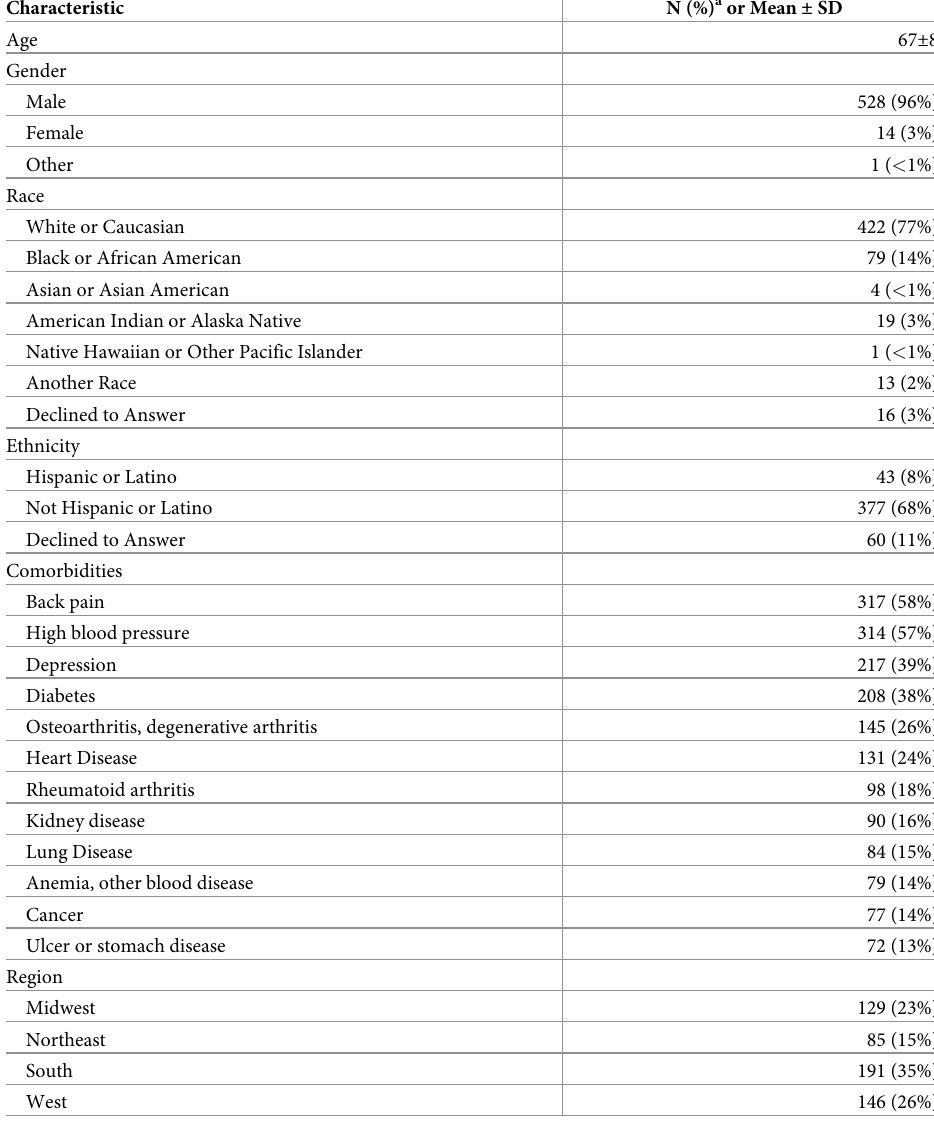
Table 1. Respondent characteristics (N =